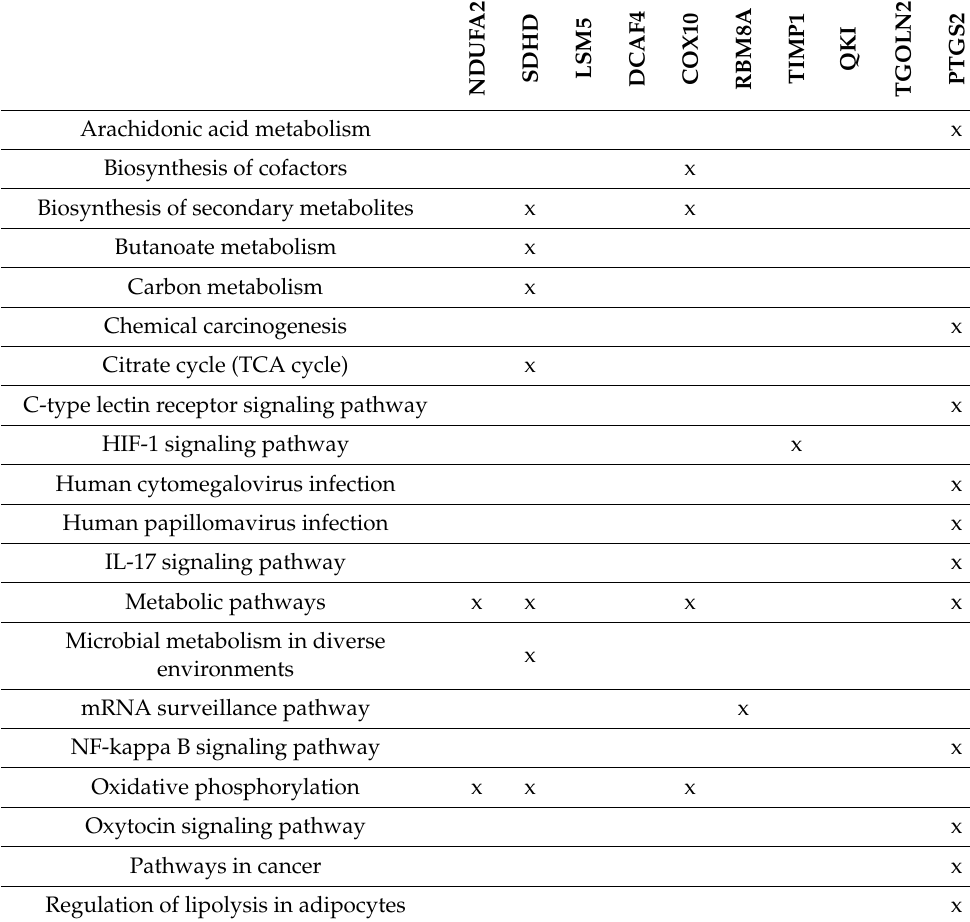
Table 3. Involvement of the top networking DEGs in significant KEGG pathways. Gene enrichment analysis of the DEGs involved in resistance of CRC patients treated with FOLFIRI (GSE62080 database) and their involvements in significant KEGG pathways using KEGG PATHWAY database